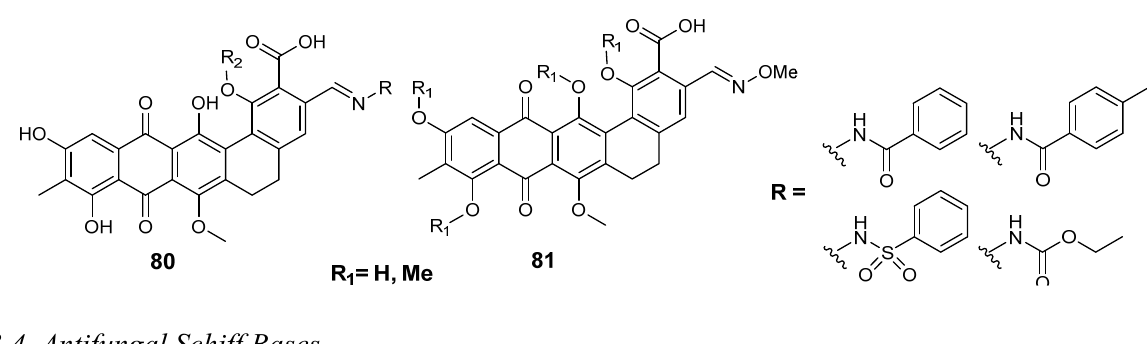
Figure 8. Madurahydroxy lactones Schiff bases.